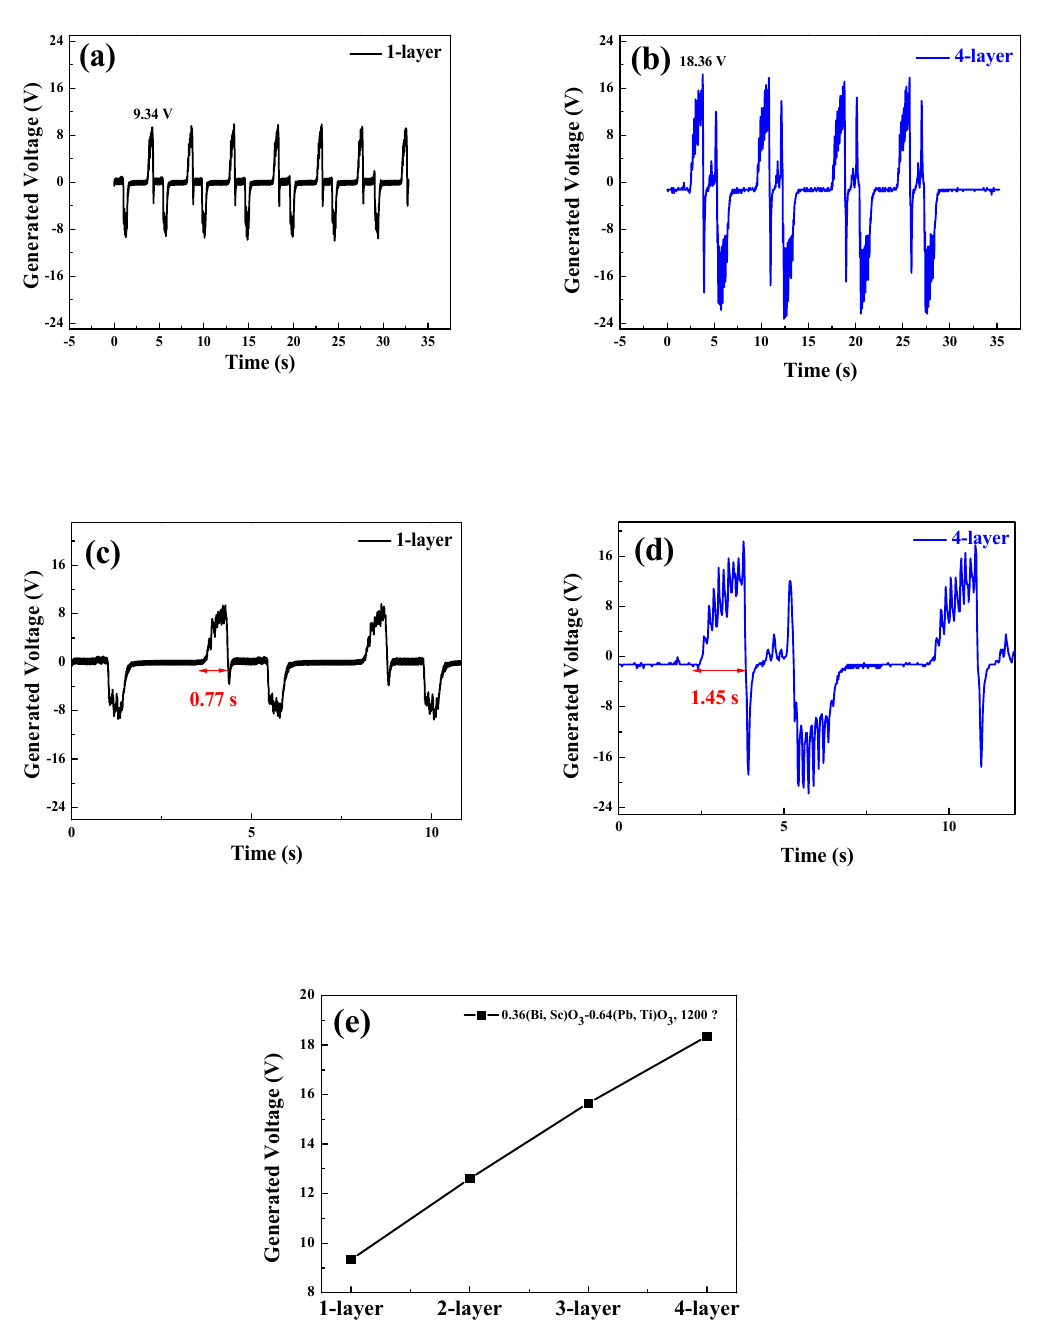
Figure 7. Generated voltage and duration time for single- and quadruple-layered piezoelectric BS-PT energy harvesters with a frequency of 0.2 Hz ( a ), ( b ). ( c ) and ( d ) show a detailed figure of (a) and (b) to show elongated generation time more clearly for the single- and quadruple-layered BS-PT energy harvesters with a frequency of 0.2 Hz. ( e ) Peak voltage measurements for the 1-4 layer BS-PT piezoelectric energy harvesters.